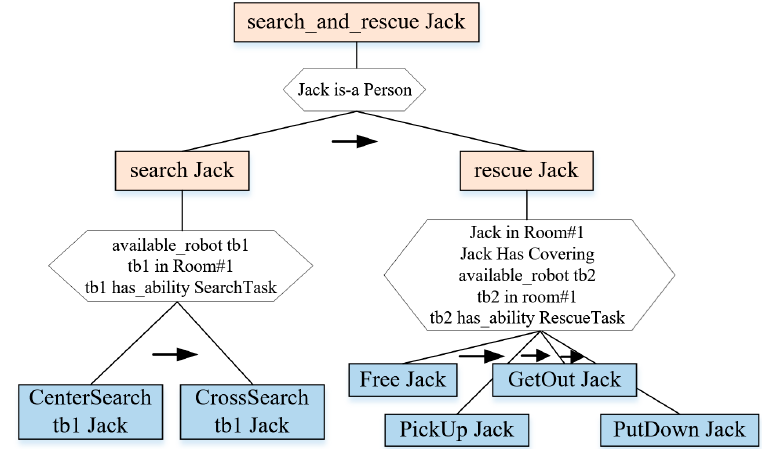
Figure 9. An example of task planning process.